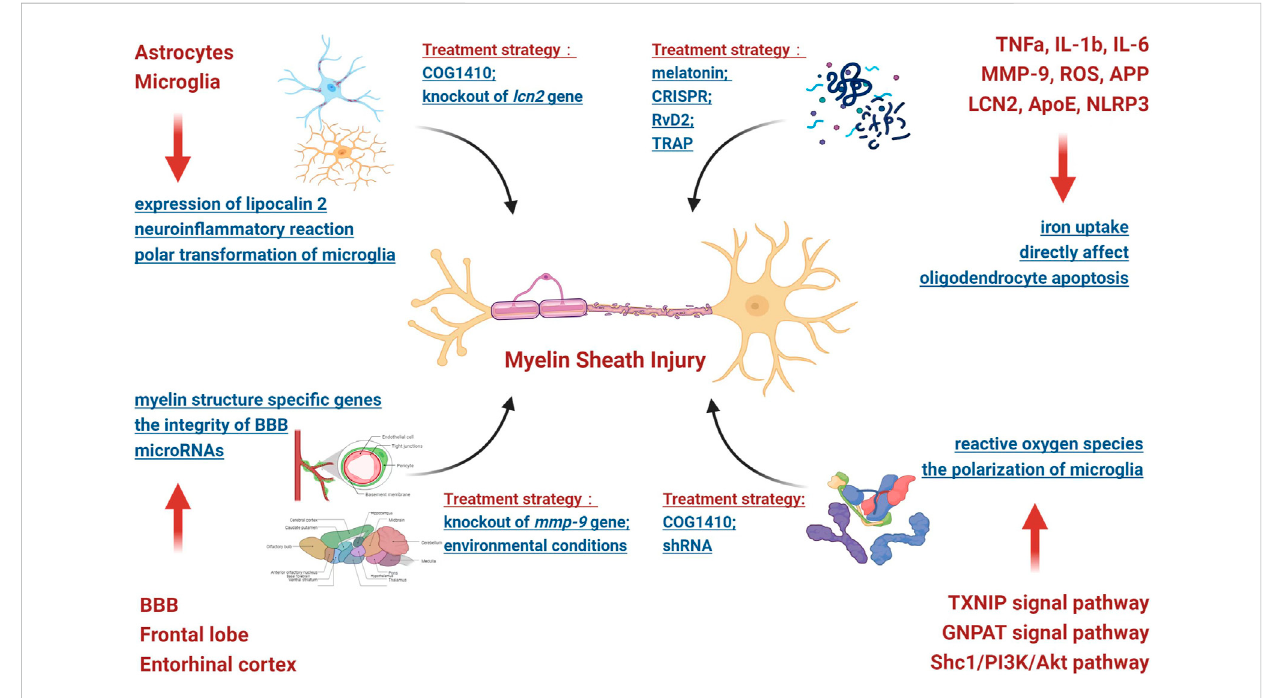
FIGURE 1 Pathophysiological mechanism involved in myelin sheath